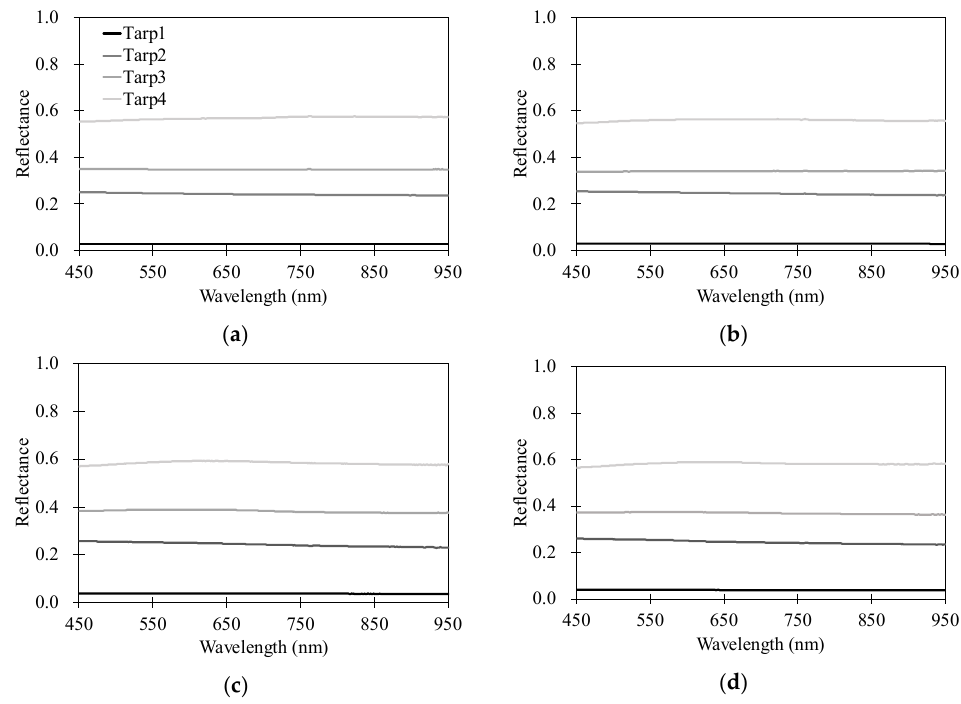
Figure 6. Hyperspectral reflectance curves corresponding to the KOMPSAT-3 and -3A spectral range (350–900 nm) measured by the dual ASD Fieldspec ® 3 radiometer system. On 14 May, 27 July, 19 and 20 September in 2017, respectively ( a – d ).